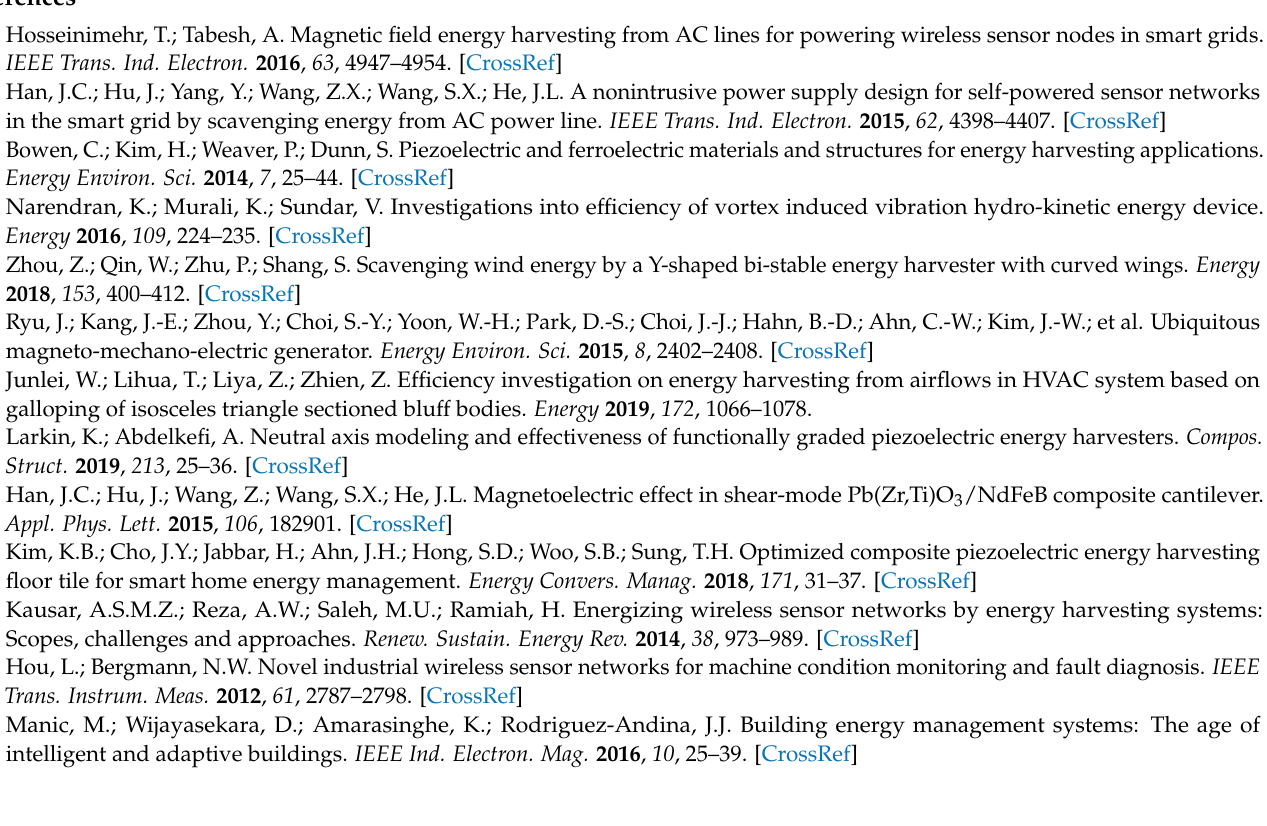
Figure S2: Maximum voltage generated from × 1, × 2, and × 4 harvesters under various applied external forces, Figure S3: (a) Output voltage generated from × 1, × 2, and × 4 harvesters under AC magnetic field of 80 µ T at 60 Hz for 10 s. (b) Maximum voltage generated from × 1, × 2, and ×